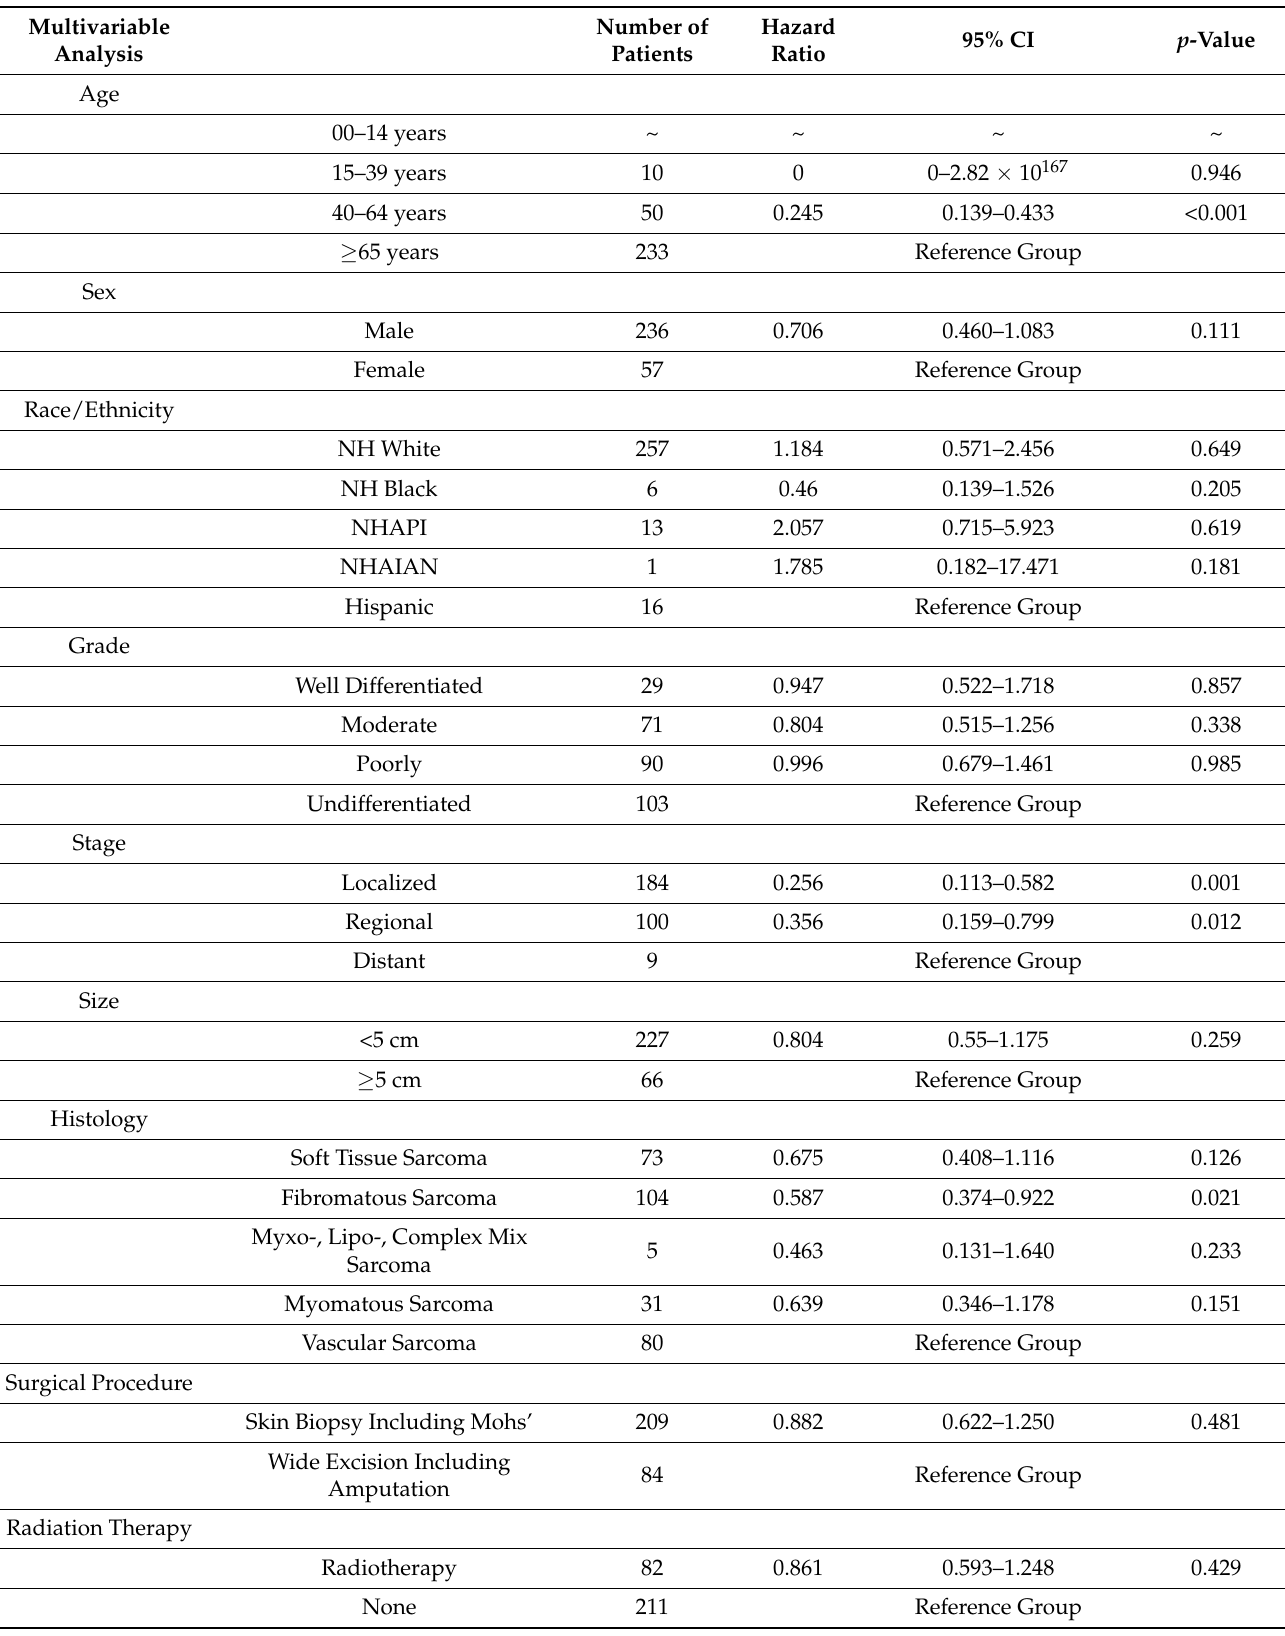
Table 3. Multivariable